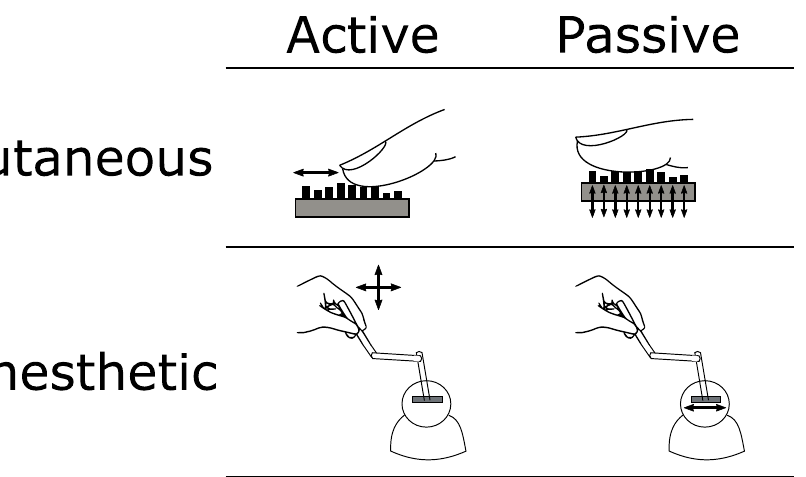
Figure 1. Classification of haptic interaction according to the exploration modality: cutaneous active, cutaneous passive, kinesthetic active, and kinesthetic passive. These four categories cover the broadness of haptic